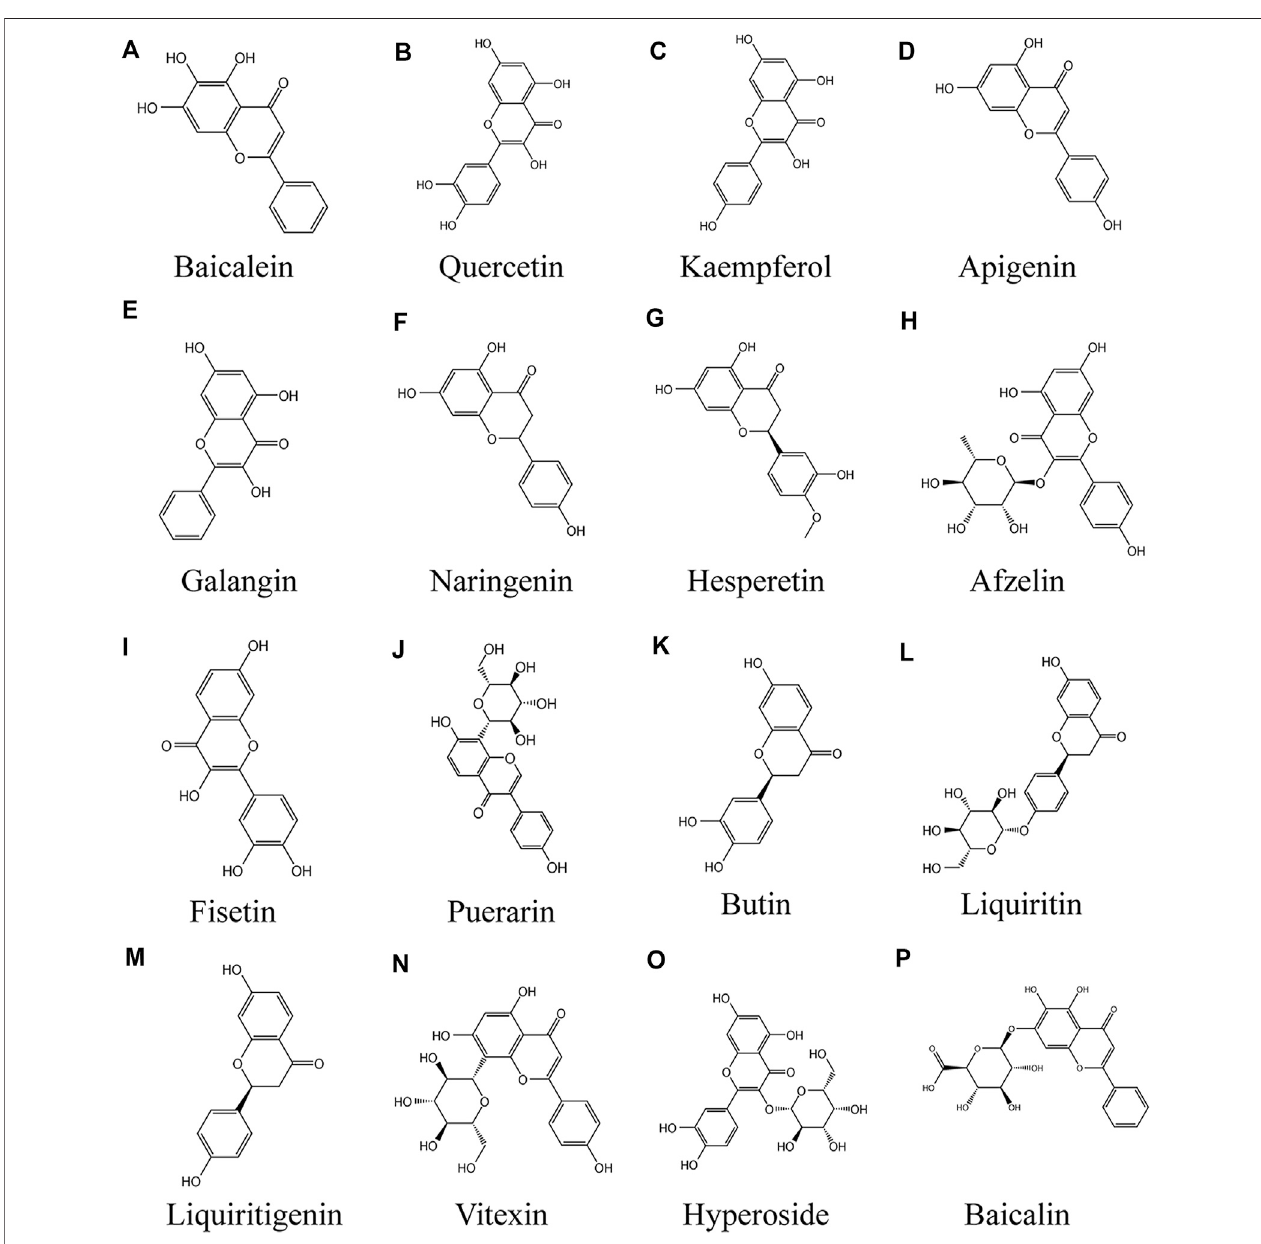
FIGURE3| Antivitiligo fl avonoids (A) Baicalein, (B) Quercetin, (C) Kaempferol, (D) Apigenin, (E) Galangin, (F) Naringenin, (G) Hesperetin, (H) Afzelin, (I) Fisetin, (J) Puerarin, (K) Butin, (L) Liquiritin, (M) Liquiritigenin, (N) Vitexin, (O) Hyperoside, (P) Baicalin.